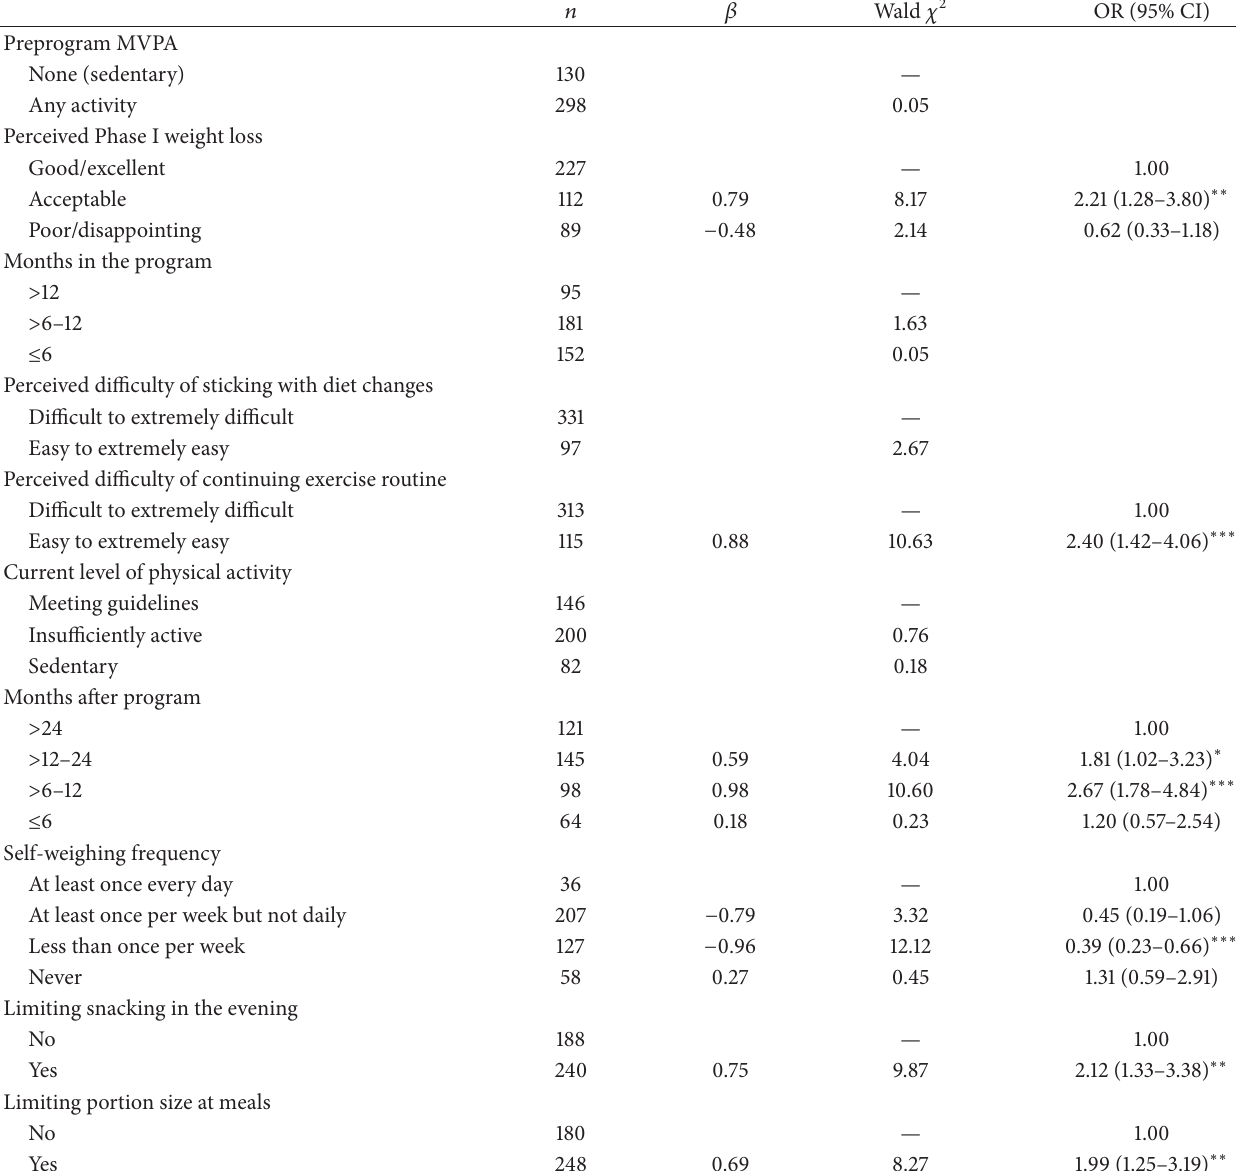
Table 6: Final model predicting weight loss maintenance ( 𝑁 = 428